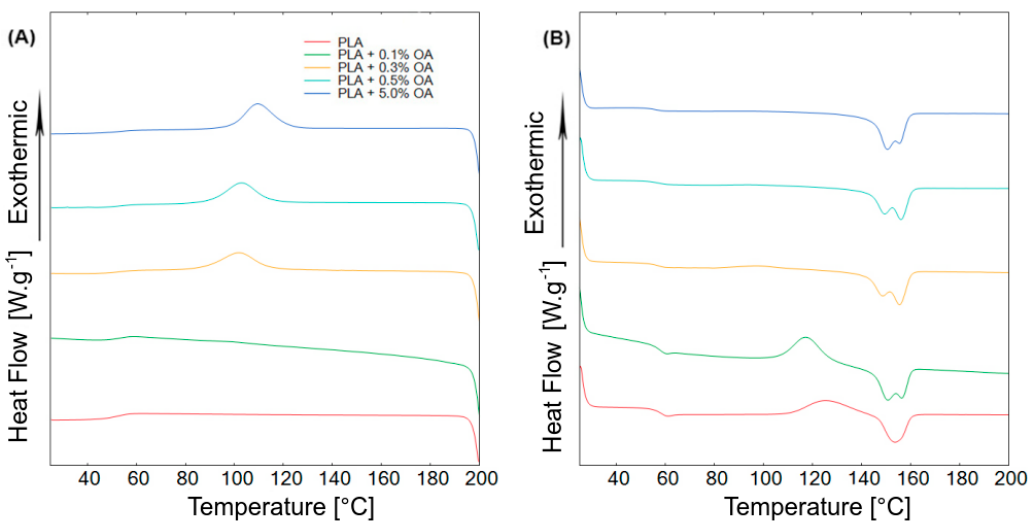
Figure 2. Differential scanning calorimetry. ( A ) Cooling traces; ( B ) heating traces with heat/cooling rate 10 K·min − 1 .